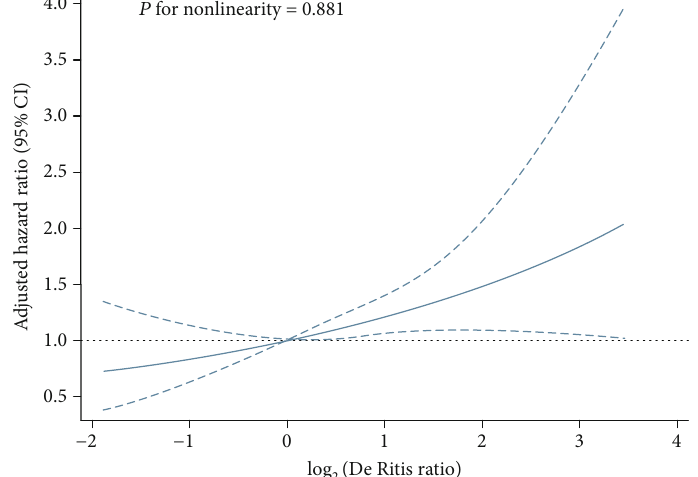
Figure 4: Cubic spline plot of the association between the log -transformed De Ritis ratio and the risk of mortality among adult onset HLH. 2 The solid line and dashed line represent the estimated hazard ratios and their corresponding 95% CIs. Analyses were adjusted for hepatomegaly, albumin (ALB), fi brinogen (FIB), EBV, ferritin, malignancy-associated HLH (MHLH), and treatment